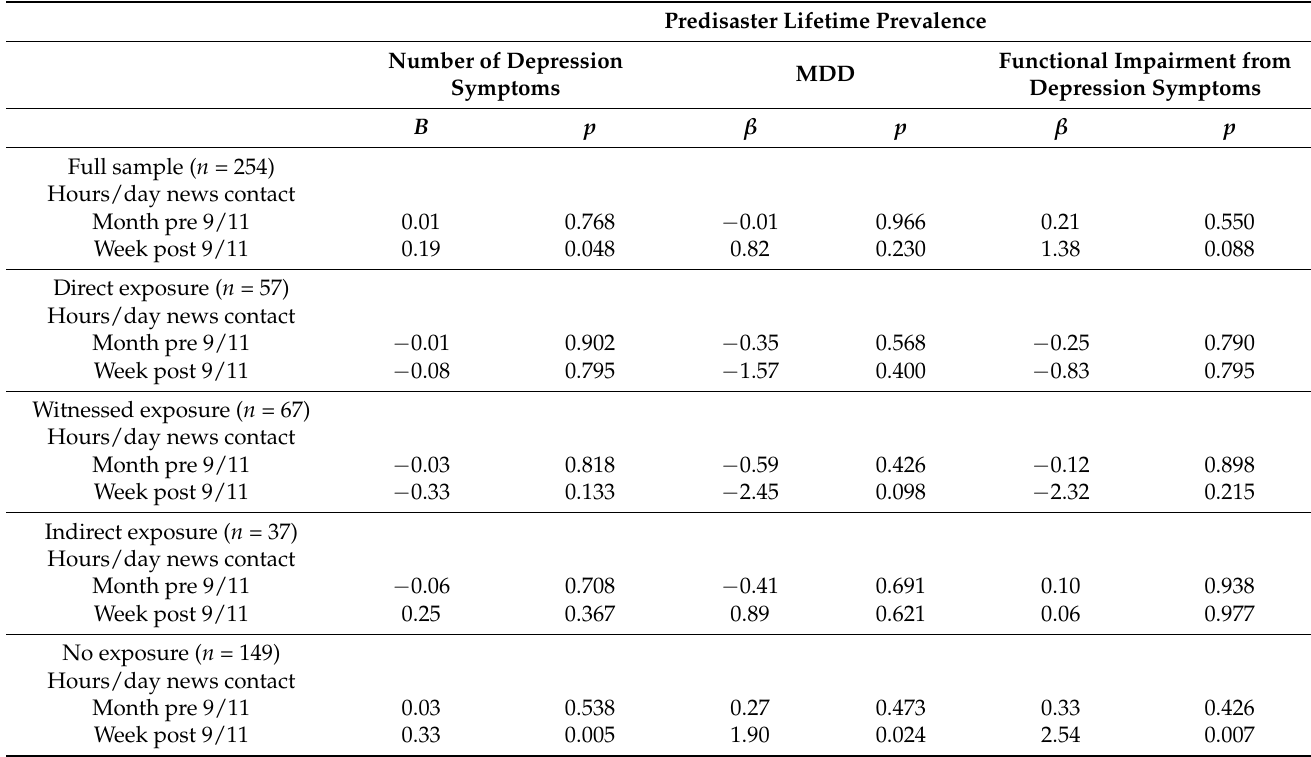
Table 1. Results from linear regression analyses for predisaster depression